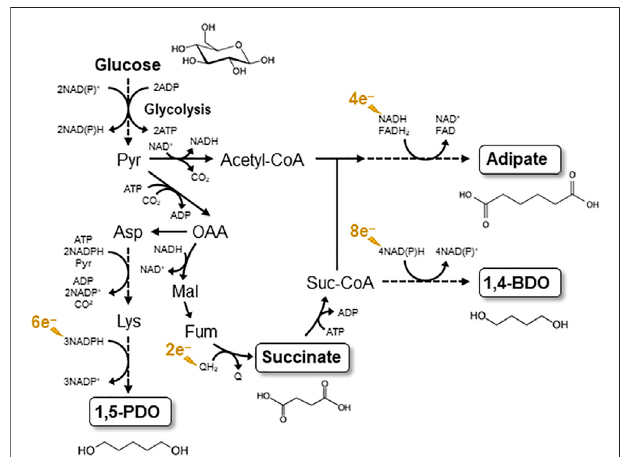
FIGURE1| Biosynthesis pathways forC4and C5diolsand dicarboxylic acids considered as target products of EF. The biosynthesis pathways are depicted based on reports by Yim et al. (2011), Zhao et al. (2018), and Cen et al. (2021). Pyr, pyruvate; Mal, malate; Fum, fumarte; Q, oxidized quinine; QH2, reduced quinone; Suc-CoA,